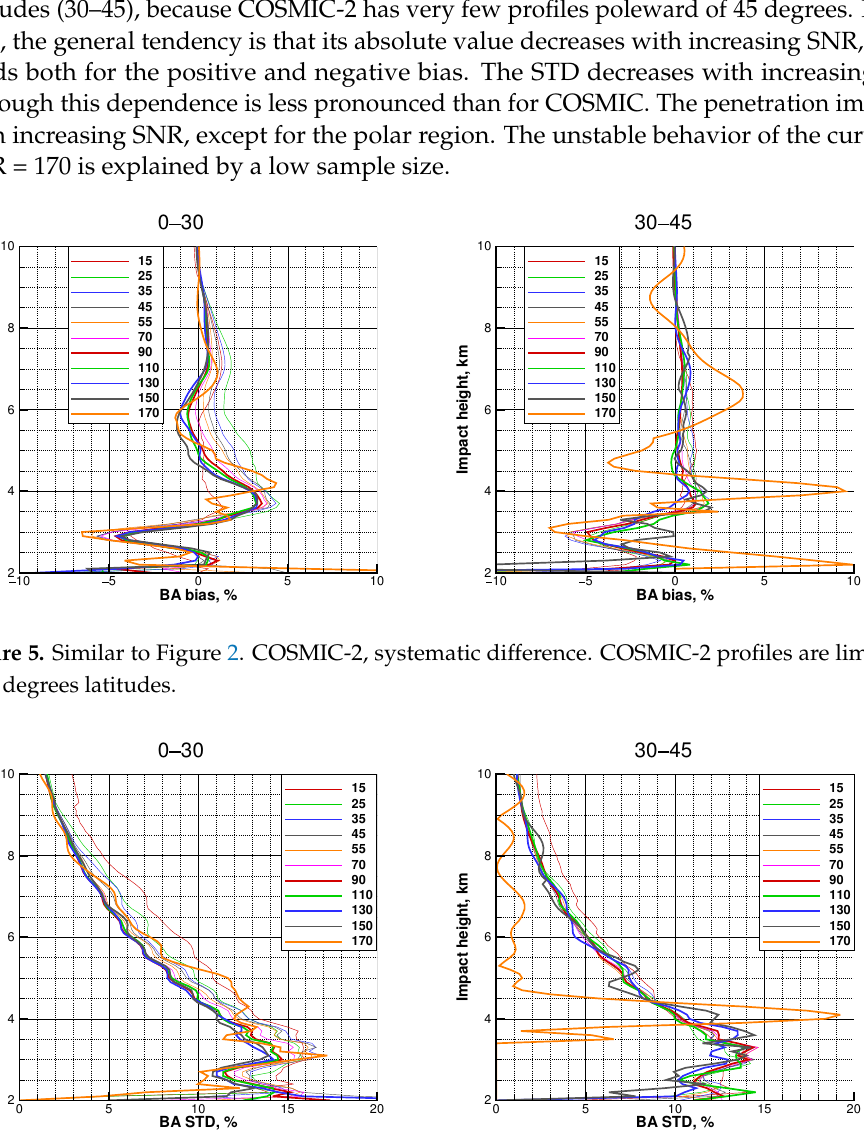
Figure 6. Similar to Figure 3. COSMIC-2, standard